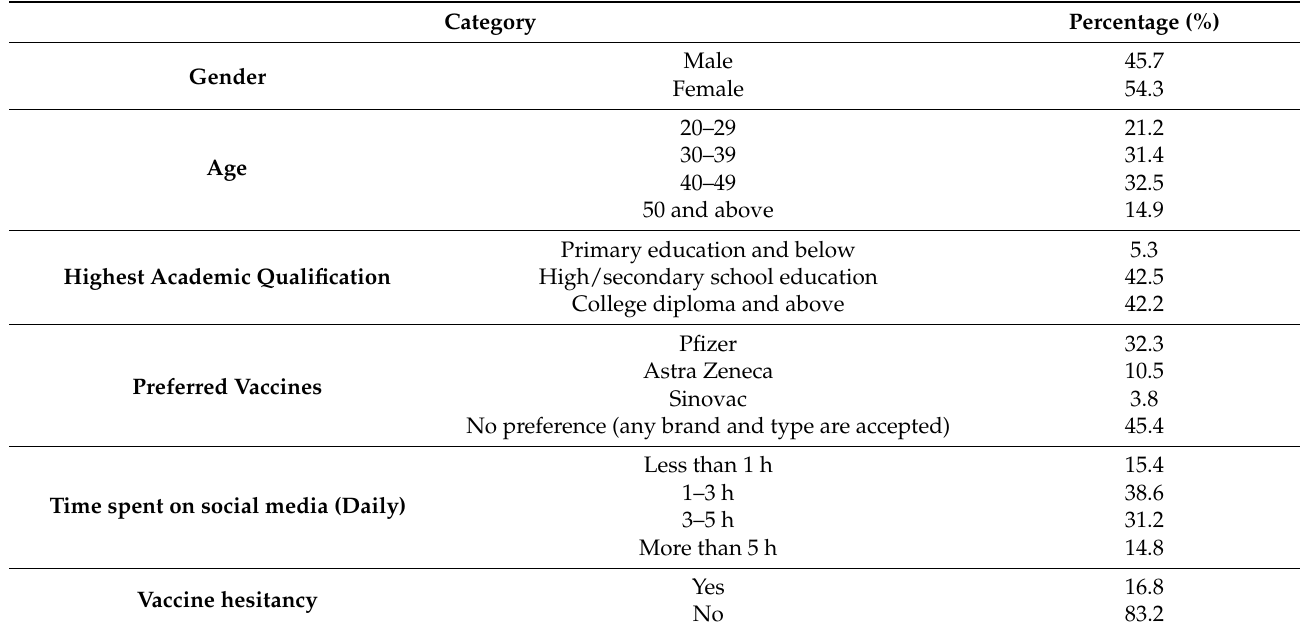
Table 1. Demographic statistics of the respondents ( n =